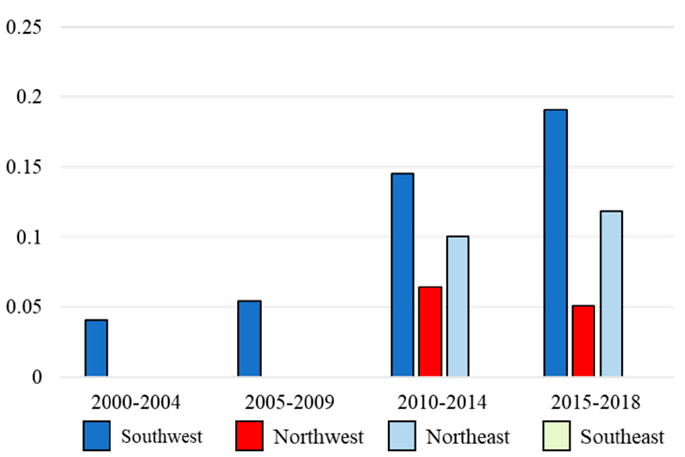
Figure 9. Evolution of the average innovation structure index of the tertiary industry of units in each area.